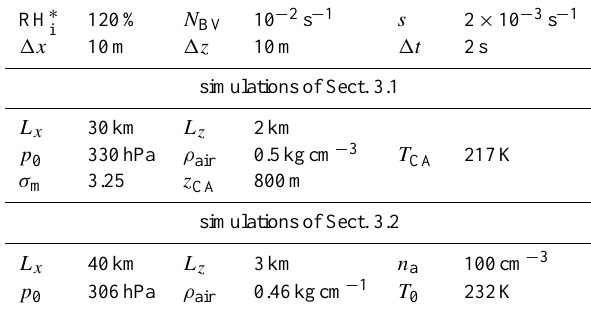
Table 1. Meteorological and numerical parameter values used in the deposition/sublimation/sedimentation sensitivity study in Sect. 3.1 and the nucleation study in Sect. 3.2: initial ambient humidity RH ∗